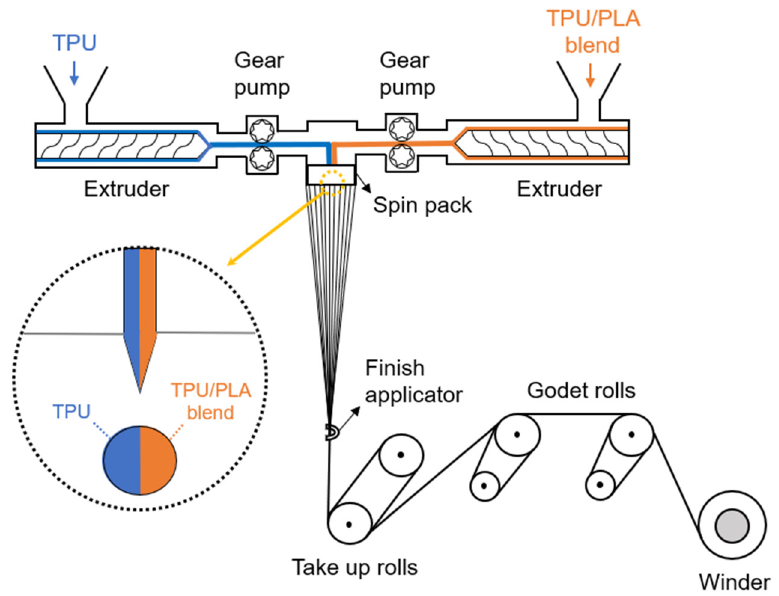
Figure 2. Schematic diagram of the preparation of TPU/(TPU/PLA) side-by-side bicomponent